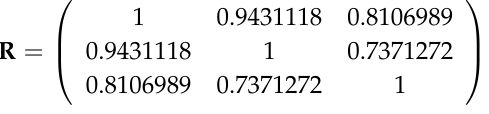
Table 8. VIFs of regression Equation (16) for λ ( 2 ) equal to λ